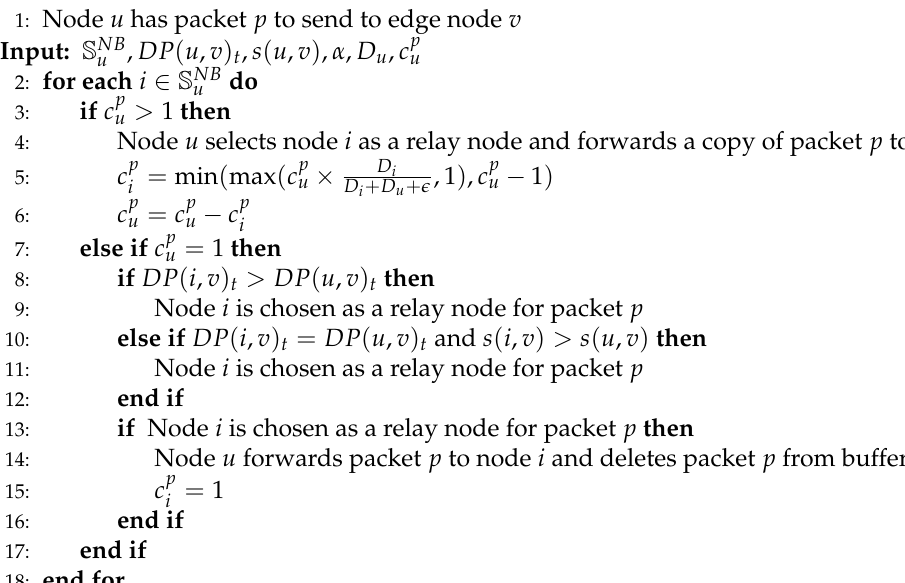
Algorithm 1 The forwarding